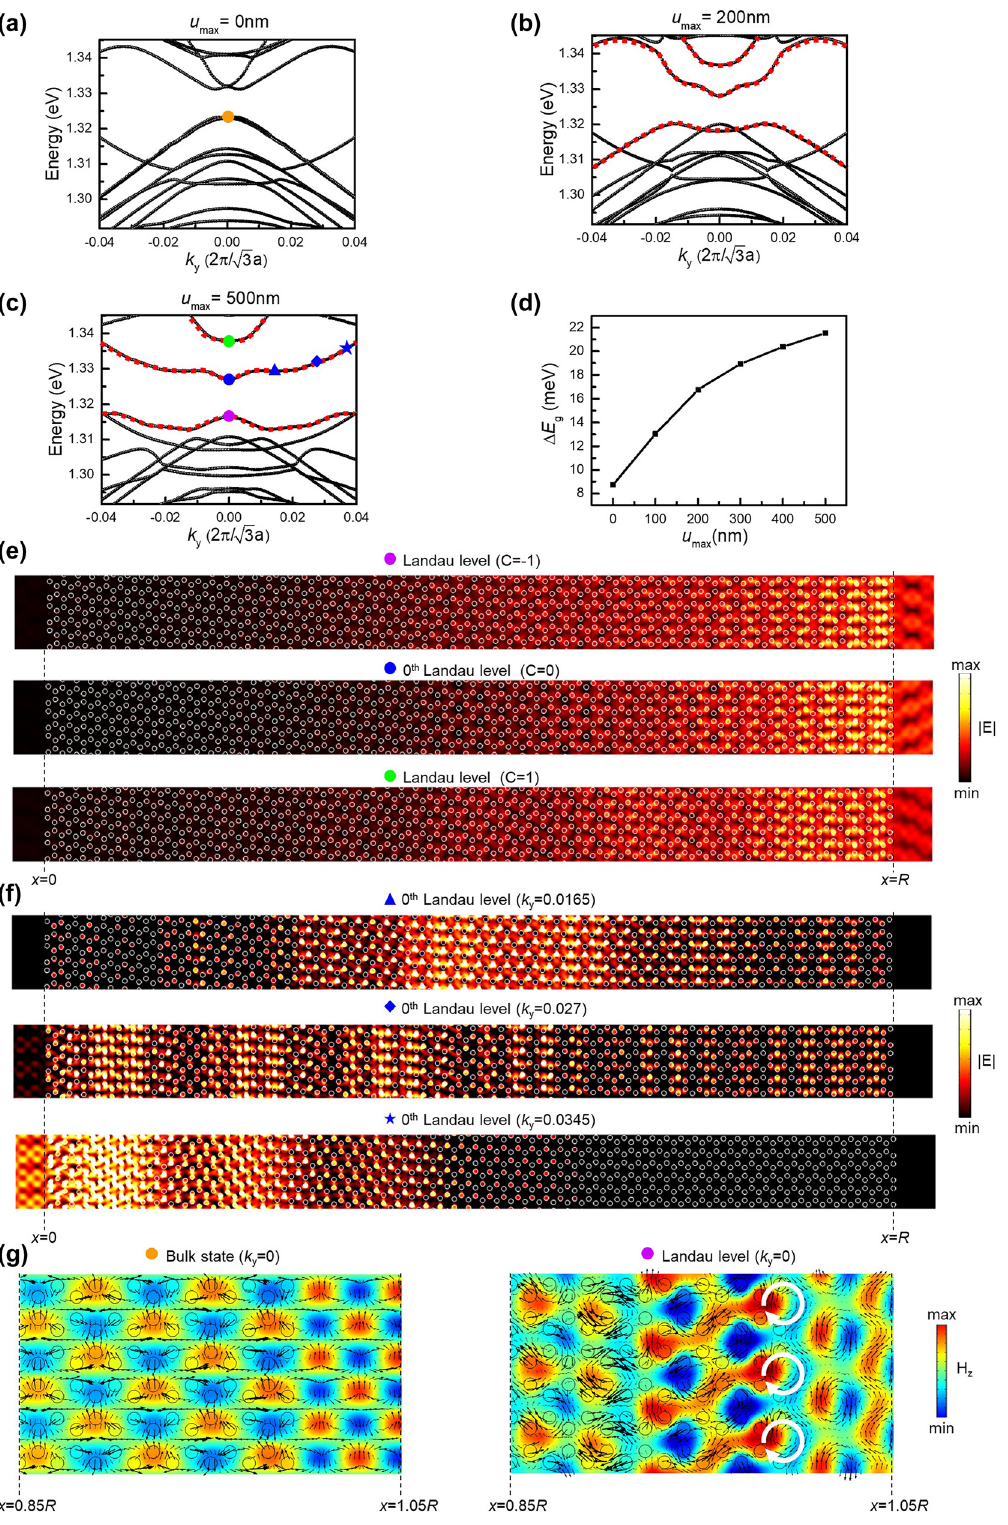
Figure 3: The appearance of photonic Landau levels. (a) – (c) The band diagram when u max equals 0 nm (a), 200 nm (b), and 500 nm (c), respectively. The red dot lines in (b) and (c) indicate the photonic Landau levels. (d) Δ E g as the function of u max . (e) The electric fi eld distribution of the three photonic Landau levels at the Γ point and thecorrespondingvalleyChernnumber.(f)Theelectric fi elddistributionsofthe0thphotonicLandaulevelat0.0165,0.027,and0.0345of k y in (c).(g)Thedistributionsofmagnetic fi eldinthe z -component H z attherightendsofourstructures,wheretheblackarrowsindicatethein-plane electric fi eld vector. The left side of g is the bulk state of the unstrained structure, and the right side is that of the strained structure, which is also indicated as an orange and purple dot in (a) and (c),